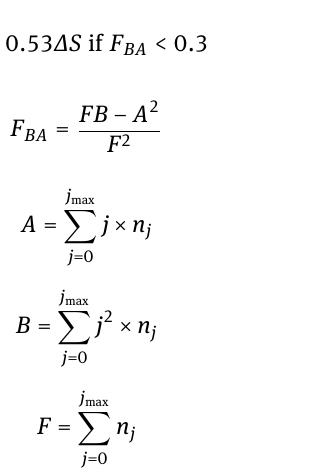
Figure 4: Staircase test results of S34MnV steel. Table 3: Summary of fatigue test results by staircase